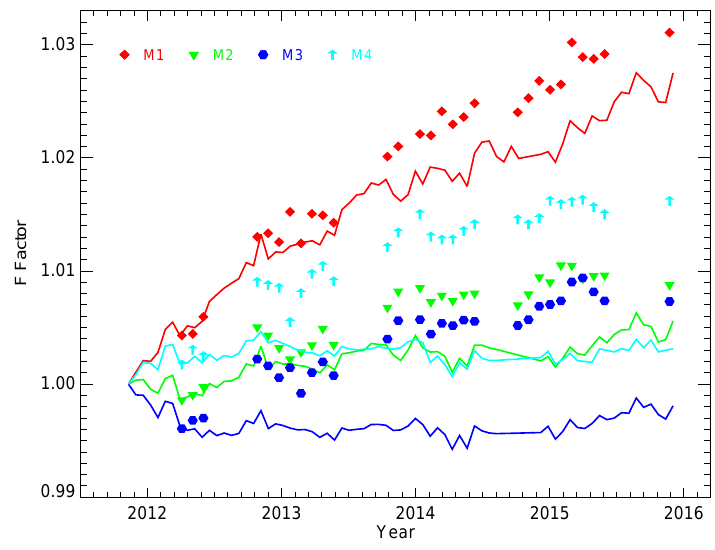
Figure 12. SNPP VIIRS RSB SD F-factors (lines) and lunar F-factors (symbols).